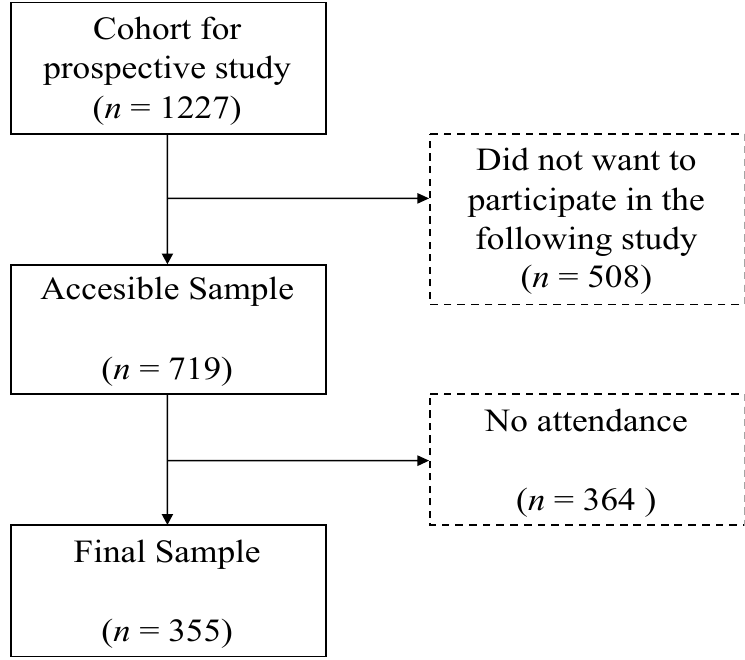
Figure 1. Flow diagram of the process of obtaining the final sample of the study.